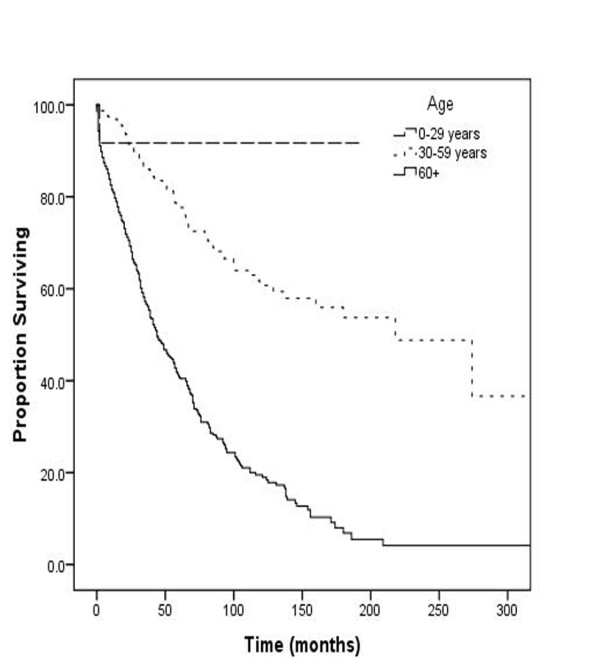
Overall Survival stratified by Age.